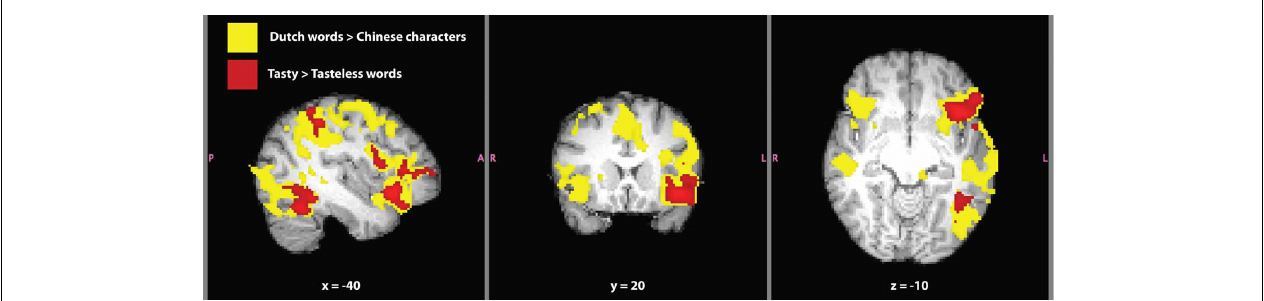
FIGURE 5 | Written language localizer for synesthete SC. Significant activation for the contrasts Dutch words > Chinese characters (yellow) and tasty > tasteless words (red) are shown. Masks of whole-brain Z -statistic values are shown in MNI space, with SC’s normalized brain as the